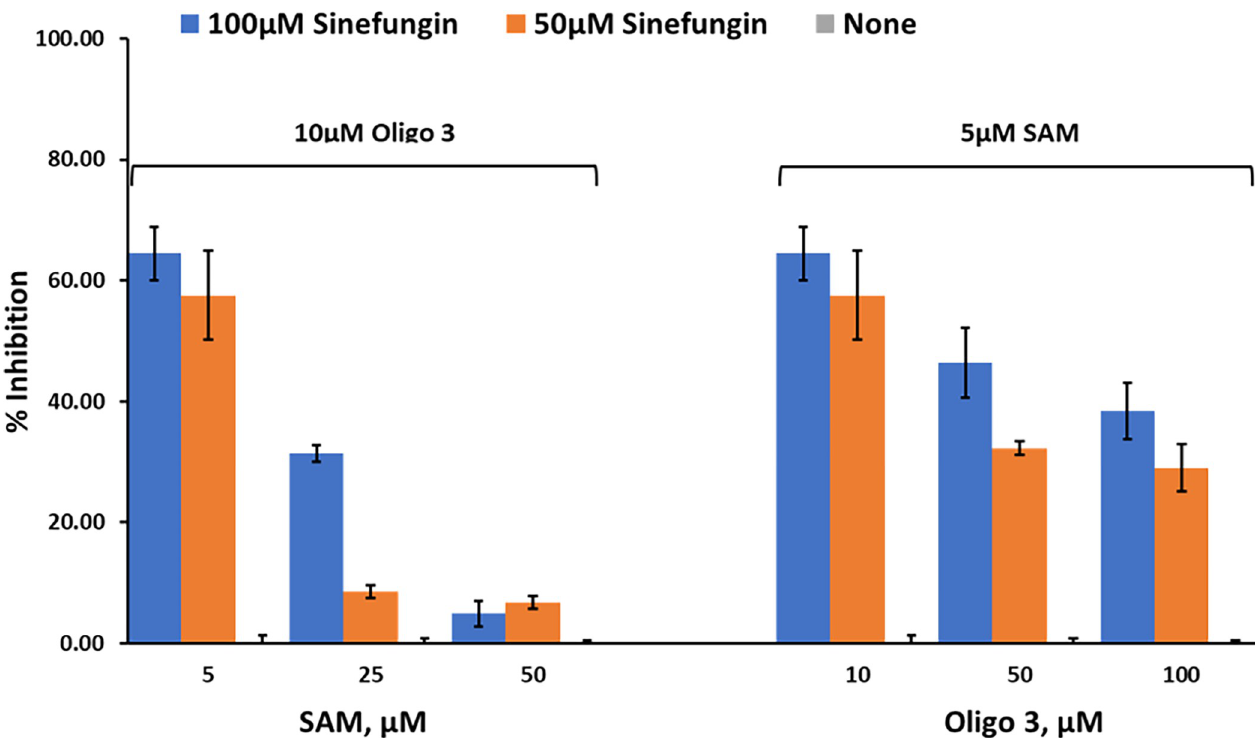
Fig 8. Effect of inhibitors on SARS-CoV-2 nsp10/nsp16 MTase activity. Percent inhibition of sinefungin (0 μ M, 50 μ M, and 100 μ M) on the enzyme activity of SARS-CoV-2 nsp10/nsp16, at three different concentrations of SAM (5 μ M, 25 μ M, and 50 μ M) using 10 μ M oligo 3 as substrate (left panel) or different concentrations of Oligo 3 (10 μ M, 50 μ M, and 100 μ M) using 5 μ M of SAM. Reactions were carried out with 60ng of NSP10/NSP16 per reaction for 90min at 37˚C. All reactions were done using white solid 384LV-well plate, and the MTase-Glo ™ Assay was performed as described in Materials and Methods section. Each point represents an average of two data points; the error bars represent the standard deviation was performed with Microsoft 1 Excel 365 program.